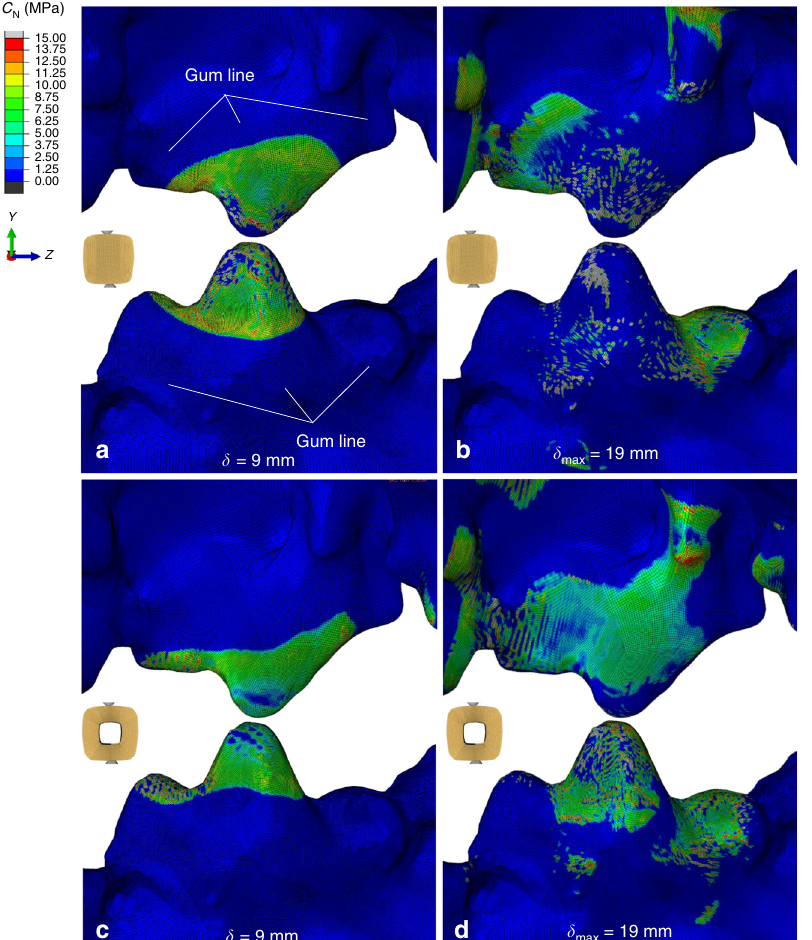
Fig. 6 Comparison of contact pressure contours. Comparison is performed at mandible displacement 9 mm between ( a ) solid square and ( c ) hollow square pro fi le and at maximum displacement δ max = 9 mm, between ( b ) solid square and ( d ) hollow square pro fi le. Signi fi cance is given to contact pressures applied in the gum line regions (denoted) away from the teeth